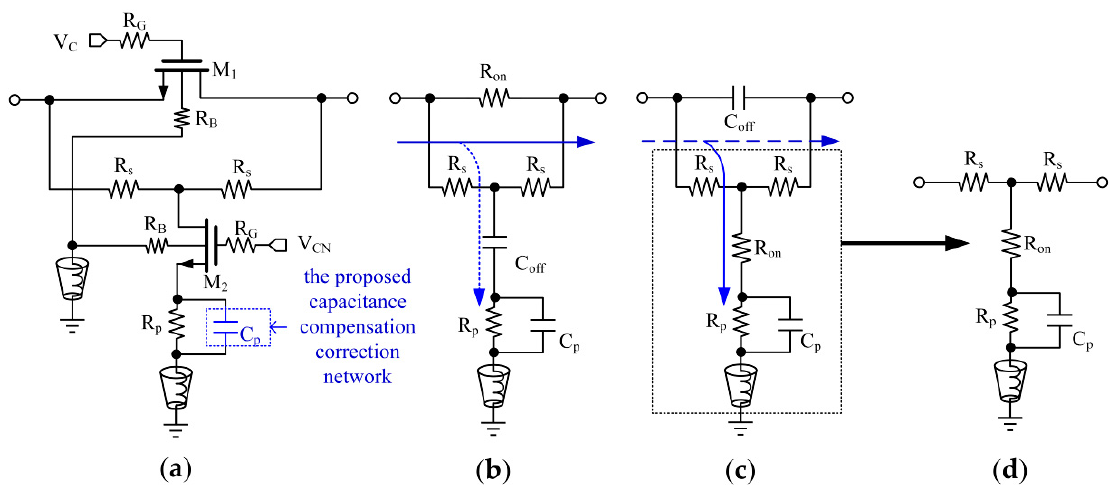
Figure 2. ( a ) The proposed T-type attenuator topology with capacitance compensation correction network; ( b ) The reference state equivalent circuit; ( c ) The attenuation state equivalent circuit; ( d ) The equivalent circuit of the capacitance compensation correction network at the attenuation state.